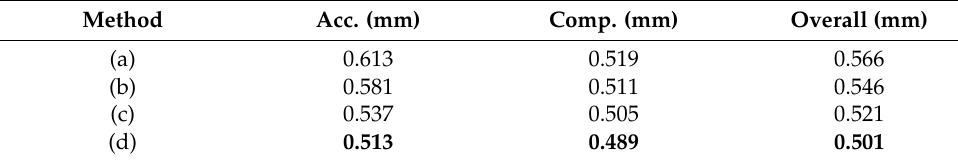
Table 3. Effect of different depth map adjustment methods.